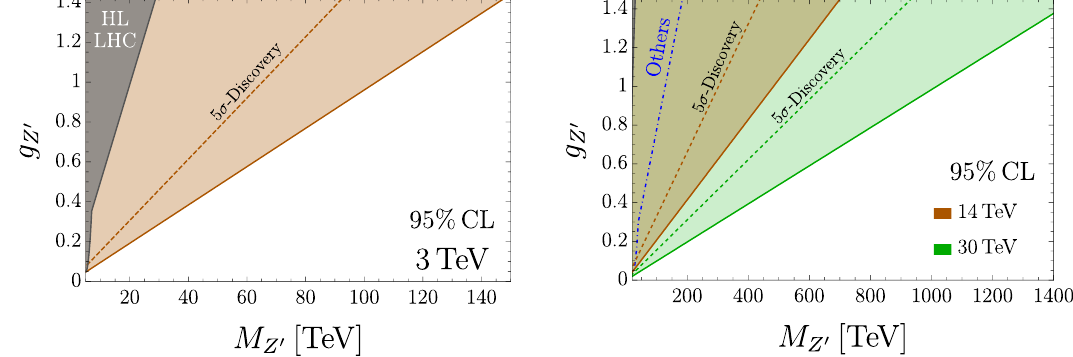
Figure 14. The same as the right panel of figure 10 for various collider